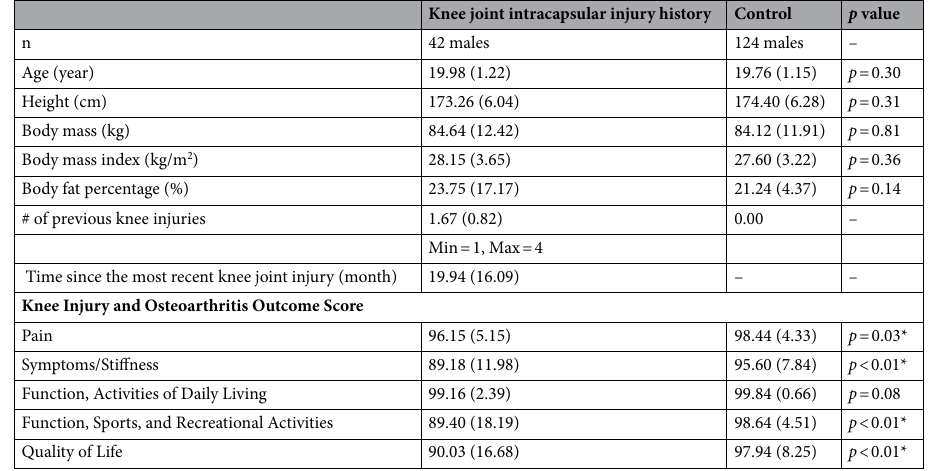
Table 1. Demographic characteristics for the traumatic knee joint injury history and control groups, mean (standard deviation). *The knee injury history group exhibited less scores on the Knee Injury and Osteoarthritis Outcome Score compared with the control groups ( p <